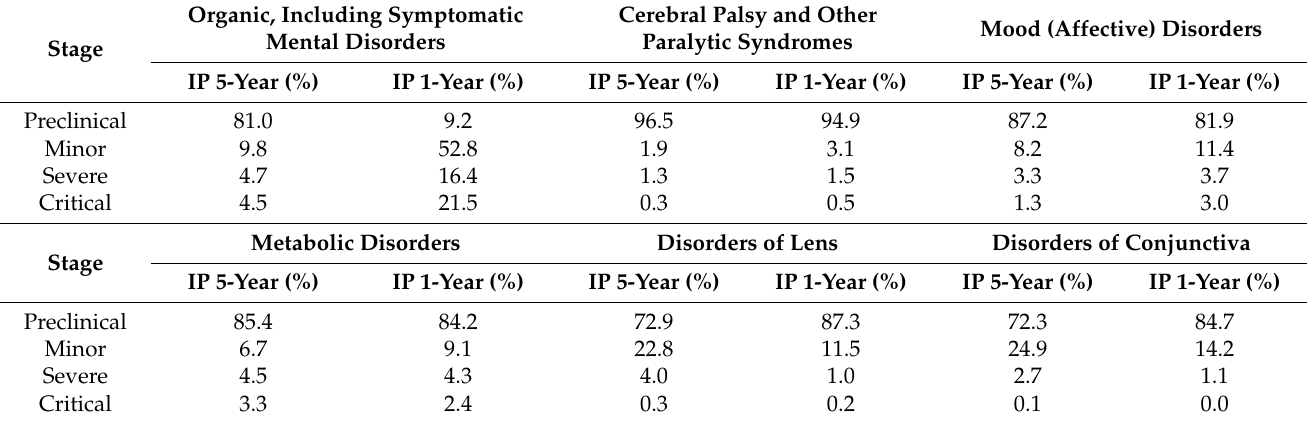
Table 11. Changes in the distribution of chronic diseases among common dementia risk